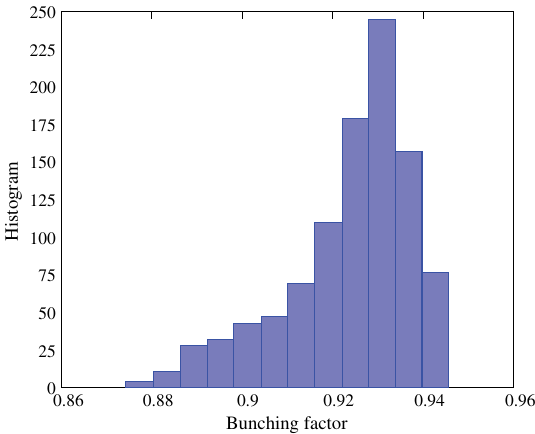
FIG. 8. Histogram of bunching factor results for 1000 different simulations where amplitude and phase for each laser lines vary randomly from their design values by 10% and 0.5 radians, respectively.